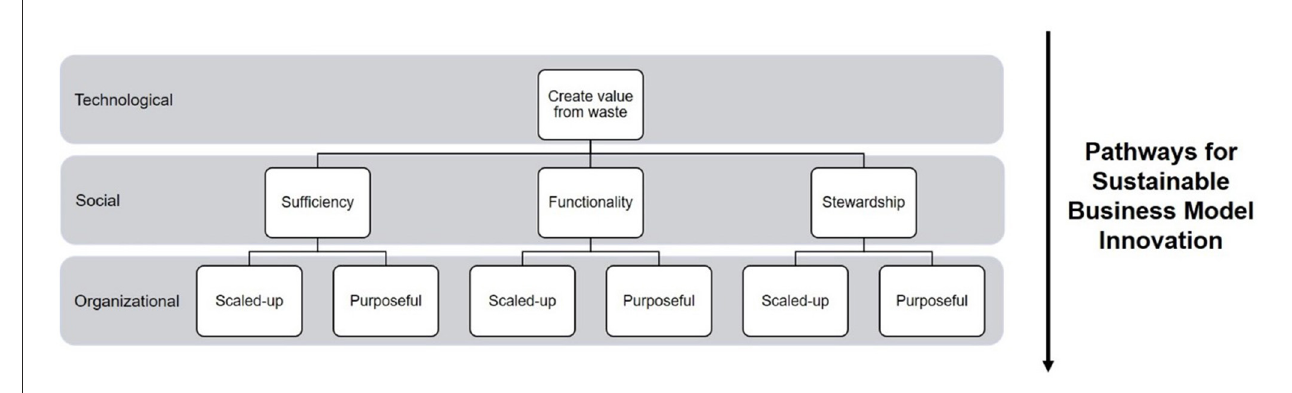
FIGURE2 Hierarchical model providing a new typology of